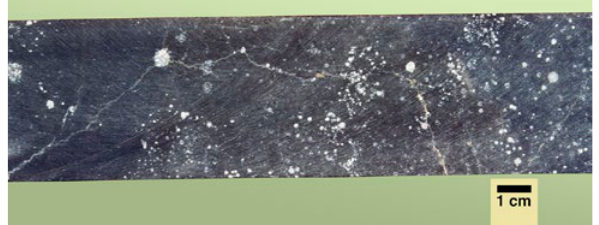
Figure 17. This shaly porphyroid intersected in drilling at the Dal- garanga Prospect west of Mt Morgan in Western Australia contains small ovoids of quartz. Some of these can be seen to be aggregates of small ovoids or fragments of the pre crystalline polymeric sili- ca. This is clear evidence of their accretionary origin (From Elliston, 2017, p.129).